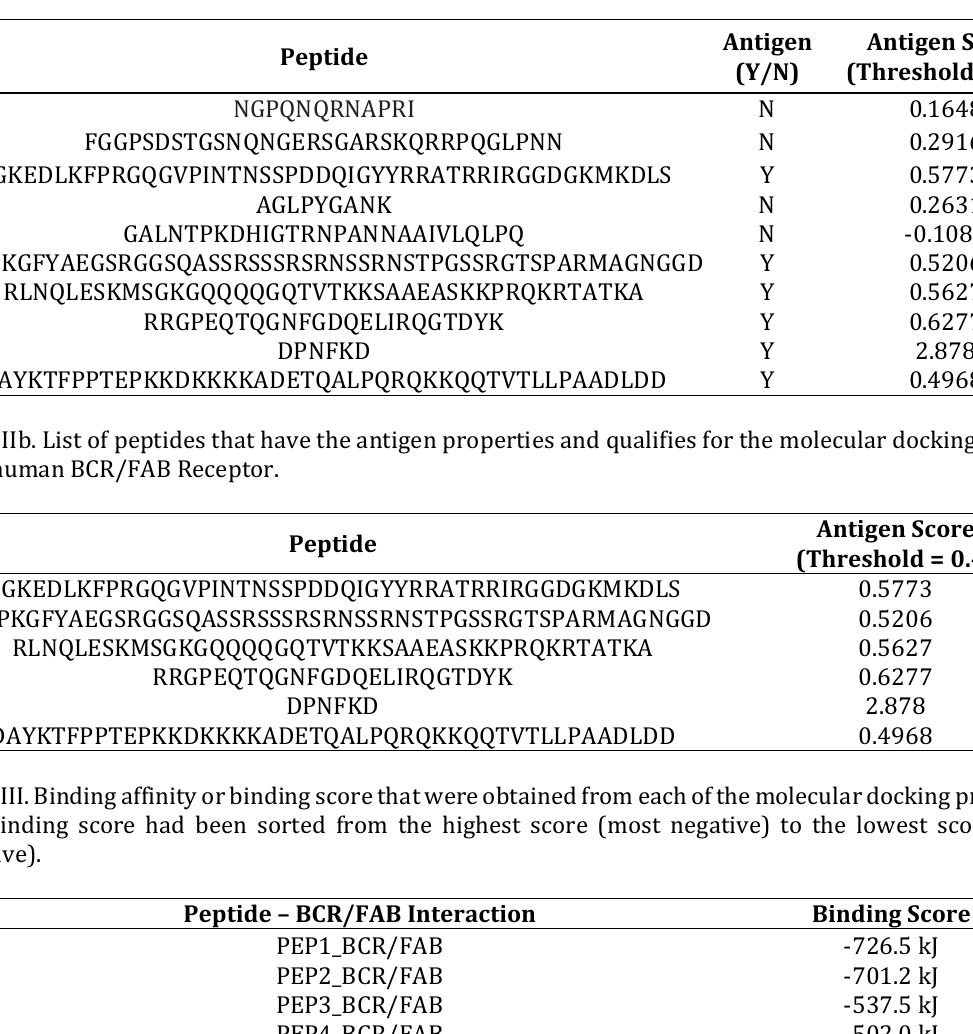
Table IIa. List of peptides generated from the B-cell epitope prediction using IEDB analysis tools, and their antigenicity prediction results which have been calculated by using the VaxiJen v2.0. Peptides that have antigen scores above the threshold proceeded to the molecular docking process.